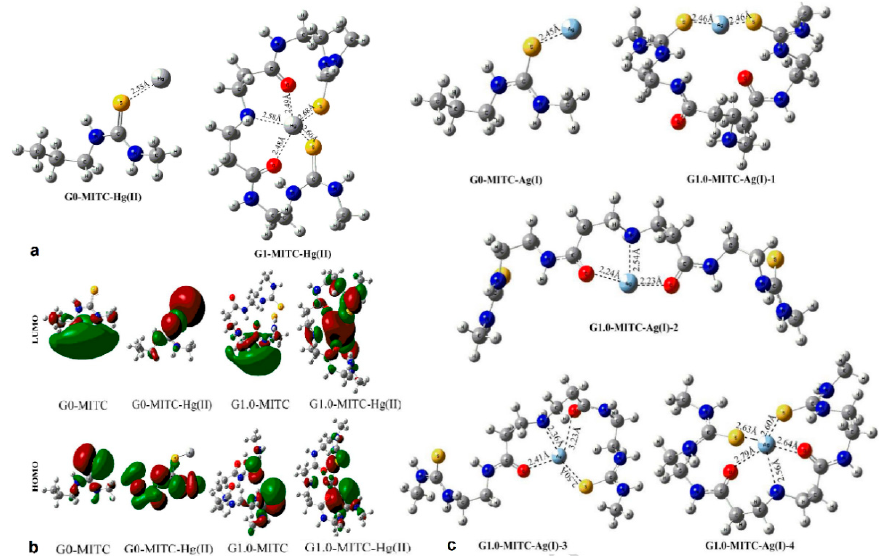
Figure 13. Optimized geometries ( a ) and contour plots ( b ) of the highest occupied molecular orbitals HOMOs (red) and lowest unoccupied molecular orbitals LUMOs (green), of Hg 2+ complexes with methylisothiocyanated (MITC) G0-PA- MAM and G1.0-PAMAM. ( Reproduced with permission from [110]; Copyright American Chemical Society, 2016); ( c ) Op- timized geometries of the respective silver complexes ( Reproduced with permission from [111]; Copyright Elsevier, 2018).